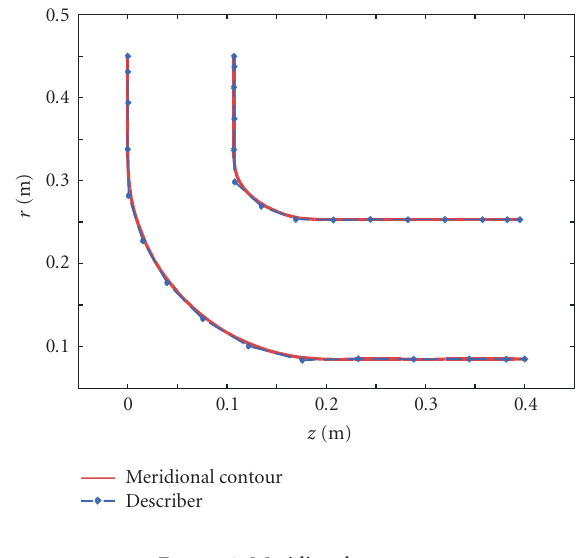
Figure 3: Meridional